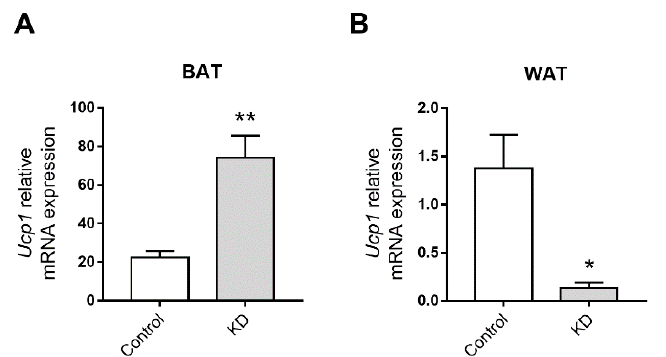
Figure 4. Effect of the ketogenic diet (KD) on the transcription levels of Uncoupling protein 1 (Ucp1) in ( A ) BAT and ( B ) WAT of ApoE − / − mice fed the experimental diets for 12 weeks. Data shown are the mean ± SEM ( n = 6–8/group). *, p < 0.05; **, p < 0.01, KD versus control.